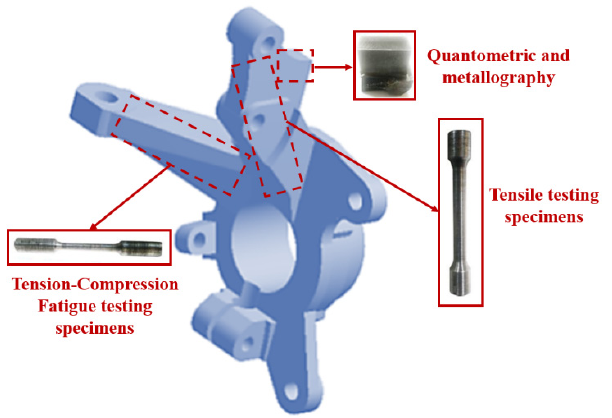
Figure 2. Fabrication of different standard samples from automotive steering knuckles for performing various material, metallurgy, and mechanical experiments. Table 1. Chemical composition (wt%) of the cast iron steering knuckle [53]. Table 3. Cyclic characteristics of ASTM A536-Grade 65-45-12